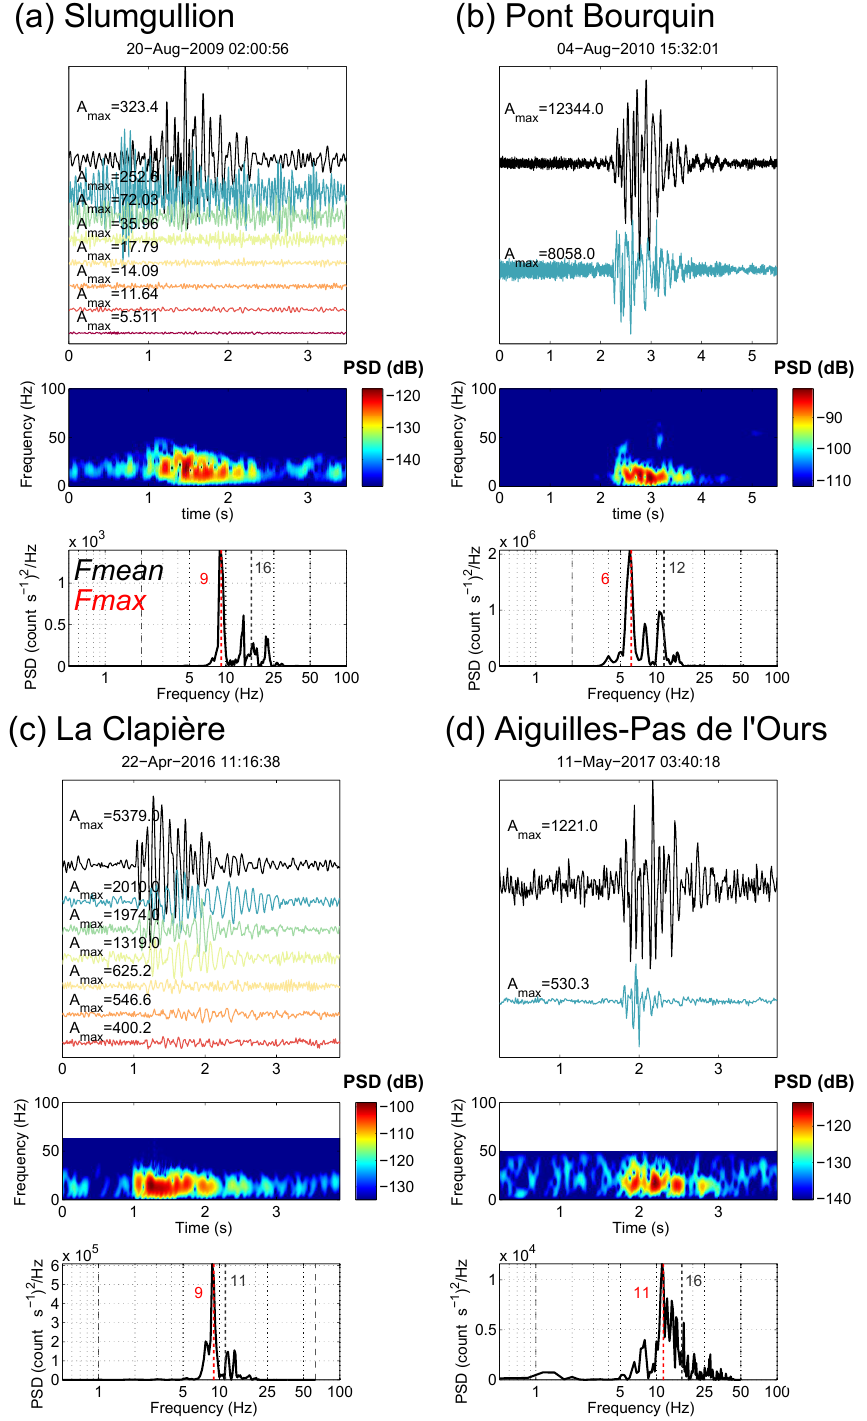
Figure 6. Low-frequency slopequakes recorded at the (a) Slumgullion (Gomberg et al., 2011), (b) Pont Bourquin, (c) La Clapière and (d) Aiguilles-Pas de l’Ours slopes. See Fig. 2 for a description of the figure. Note that for the Slumgullion signals (a) , the amplitudes are expressed in